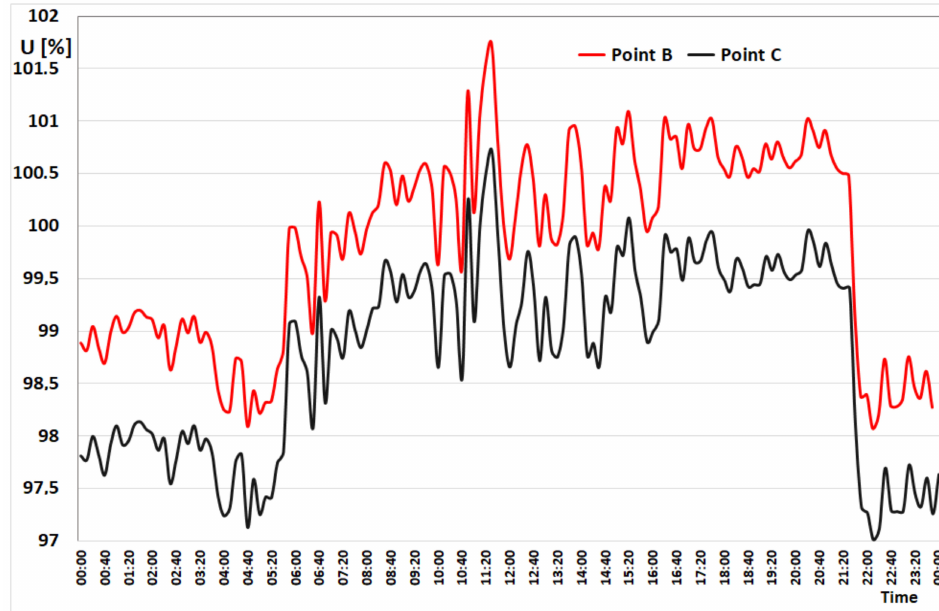
Figure 19. Voltage changes recorded at points B and C.